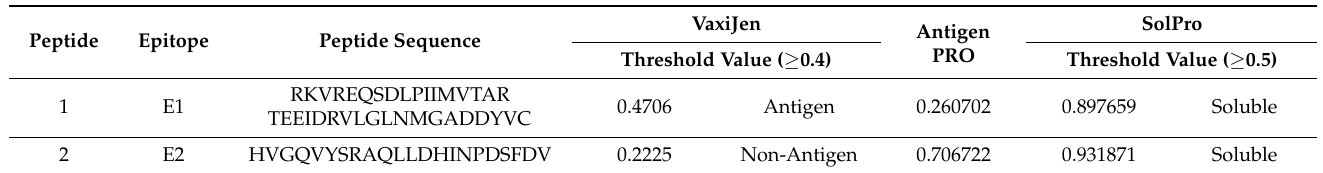
Table 2. Antigenicity and solubility analysis of the predicted BaeR epitopes using VaxiJen, ANTI- GENPro and SOLPro.